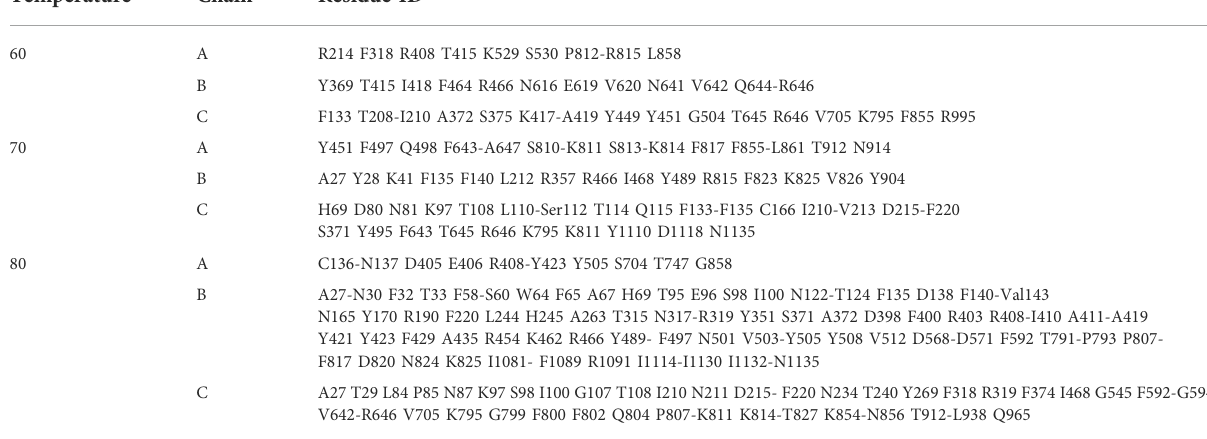
TABLE 3 Structural divergence outliers